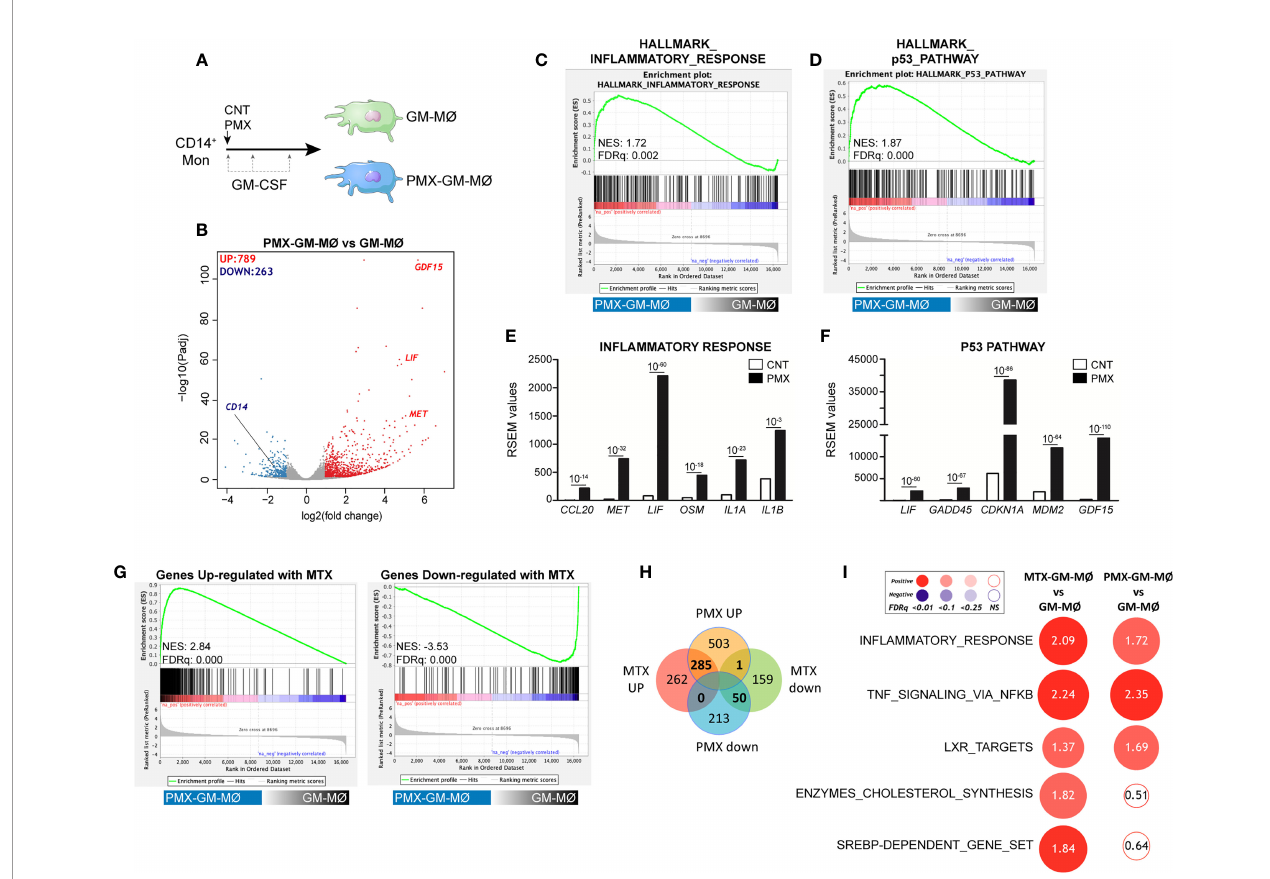
FIGURE 1 | PMX promotes the acquisition of a proin fl ammatory gene pro fi le in GM-MØ. (A) Schematic representation of the experiments. Monocytes were untreated or exposed to 50 nM of PMX at the beginning of the 7-day macrophage differentiation process with GM-CSF, and the mRNA levels were determined at day 7 on GM-MØ. (B) Volcano plot of RNAseq results showing the PMX-induced gene expression changes in GM-MØ. The number of annotated genes whose expression is upregulated or downregulated in GM-MØ after 7 days of PMX treatment (adjusted p < 0.05) is shown. (C, D) GSEA (http://software.broadinstitute.org/ gsea/index.jsp) on the ranked comparison of the transcriptome of PMX-GM-MØ versus untreated GM-MØ, using the Hallmarks v7 data set available at the web site. (E, F) RSEM expression values of the informative genes from the indicated GSEA enriched plot and found in the leading edge; adj p value is indicated. (G) GSEA on the ranked comparison of the transcriptome of PMX-GM-MØ versus untreated GM-MØ, using the genes signi fi cantly modulated by MTX in GM-MØ as data set. (H) Venn diagram comparing the genes differentially expressed by PMX in GM-MØ with the genes signi fi cantly altered by MTX in GM-MØ. (I) Summary of GSEA with the indicated gene set on the ranked comparison of the transcriptomes of MTX-GM-MØ vs . GM-MØ, and PMX-GM-MØ vs . GM-MØ. Circled area is proportional to the absolute value of the normalized enrichment score (NES), which is indicated inside the circles. The intensity of color increases with the enrichment of the gene signature (red, positive enrichment; blue, negative enrichment). False discovery rate (FDRq) is also indicated. The gene sets used were the Hallmarks (v7.2) data set available at the web site and the “ SREBP-dependent gene set ” data set (34). For panels G – I, the transcriptome data of MTX-treated GM-MØ have been previously described (21) and are available at GEO (https://www.ncbi.nlm.nih.gov/geo/) (GSE71253). PMX, pemetrexed; GM-CSF, granulocyte-macrophage colony-stimulating factor; GSEA, gene set enrichment analysis; MTX,